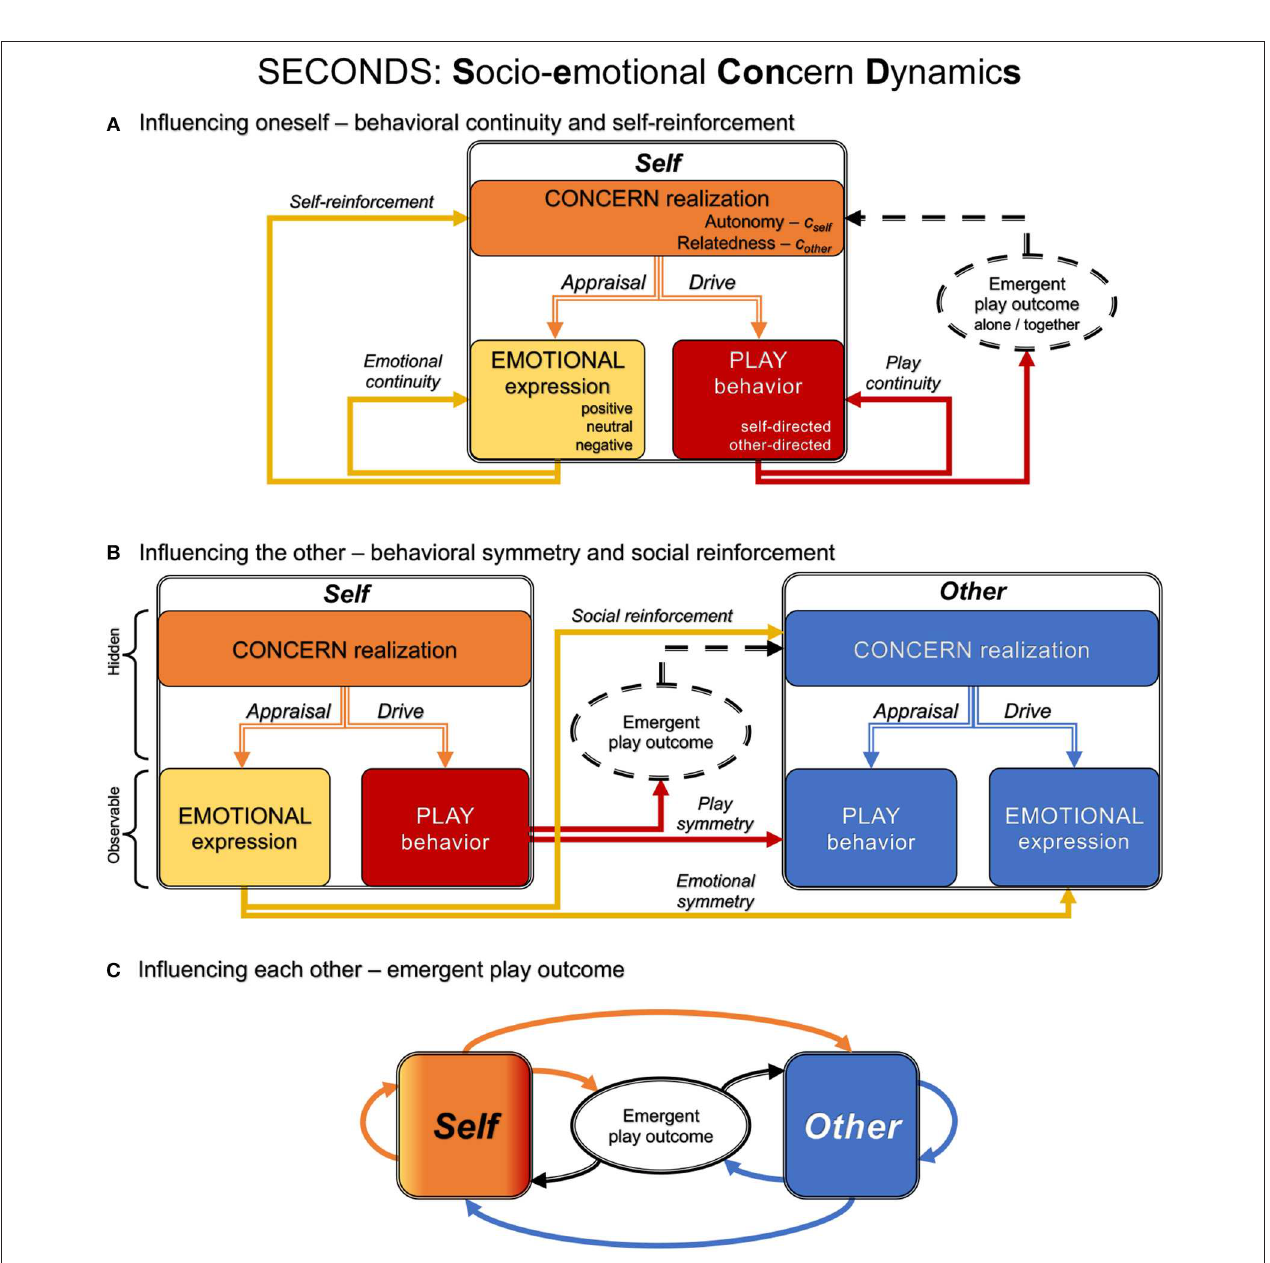
FIGURE 1 | These panels illustrate Socio-emotional Concern Dynamics (SECONDS) from the perspective of one agent ( Self ) in playful interaction with another agent ( Other ). For clarity, we first decompose SECONDS into influences of the agent on itself ( Self ⇒ Self ) in (A) , and on the other agent ( Self ⇒ Other ) in (B) . Finally, in (C) , we illustrate the full model of how their mutual influences give rise to the emergent play outcome ( Self ⇔ Other ). (A) The agent monitors the realization of its socio-emotional concerns of autonomy and relatedness ( c self , c other ; orange box). The degree of realization of the agent’s concerns produces corresponding appraisals and drives, which influence its emotional expressions (positive, neutral, or negative; yellow box) and play behaviors (self- or other-directed; red box), respectively. Emotional expressions tend to persist into the future (emotional continuity) and to modify the agent’s own concerns (self-reinforcement). Play behaviors also tend to persist into the future (play continuity) and contribute to playing alone or together in the emergent play outcome (dashed ellipse), thus impacting the agent’s concern realization (dashed black arrow). (B) We emphasize a crucial distinction between external active states, which are observable to the other ( Other ; blue), and internal states of the agent, which are hidden from the other. Emotional expressions tend to be mirrored by the other (emotional symmetry) and modify the other’s concerns (social reinforcement). Play behaviors tend to be mirrored by the other (play symmetry) and contribute to the emergent play outcome (dashed ellipse), thus impacting the other agent’s concern realization (dashed black arrow). (C) The full picture of how the recurrent play dynamics between Self (left; orange box and arrows) and Other (right; blue box and arrows) give rise to the emergent play outcome (middle; solid black ellipse and arrows). In panel c, the emergent play outcome is fully specified (indicated with solid lines), while it is only partially specified in panels a and b (indicated with dashed lines). See Table 1 for a more technical summary of SECONDS.